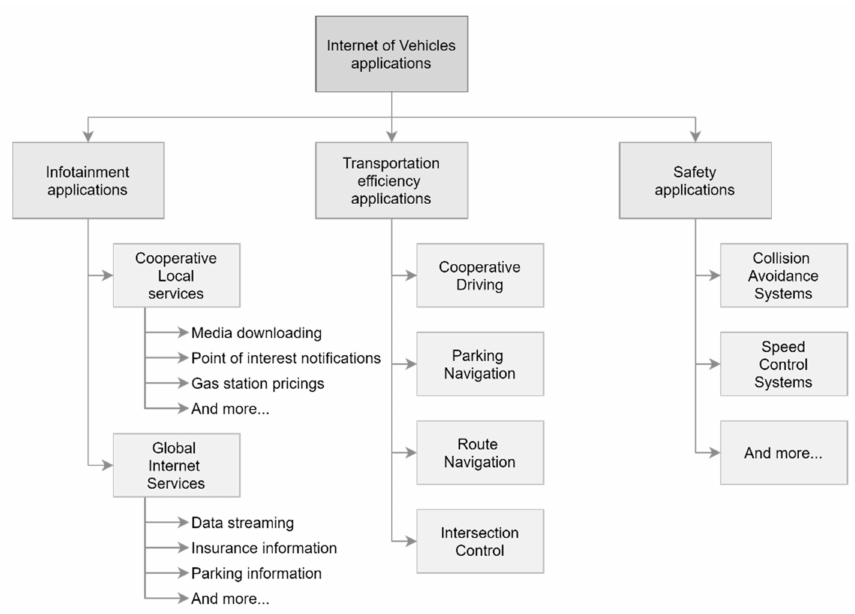
Figure 4. Taxonomy of applications for the Internet of